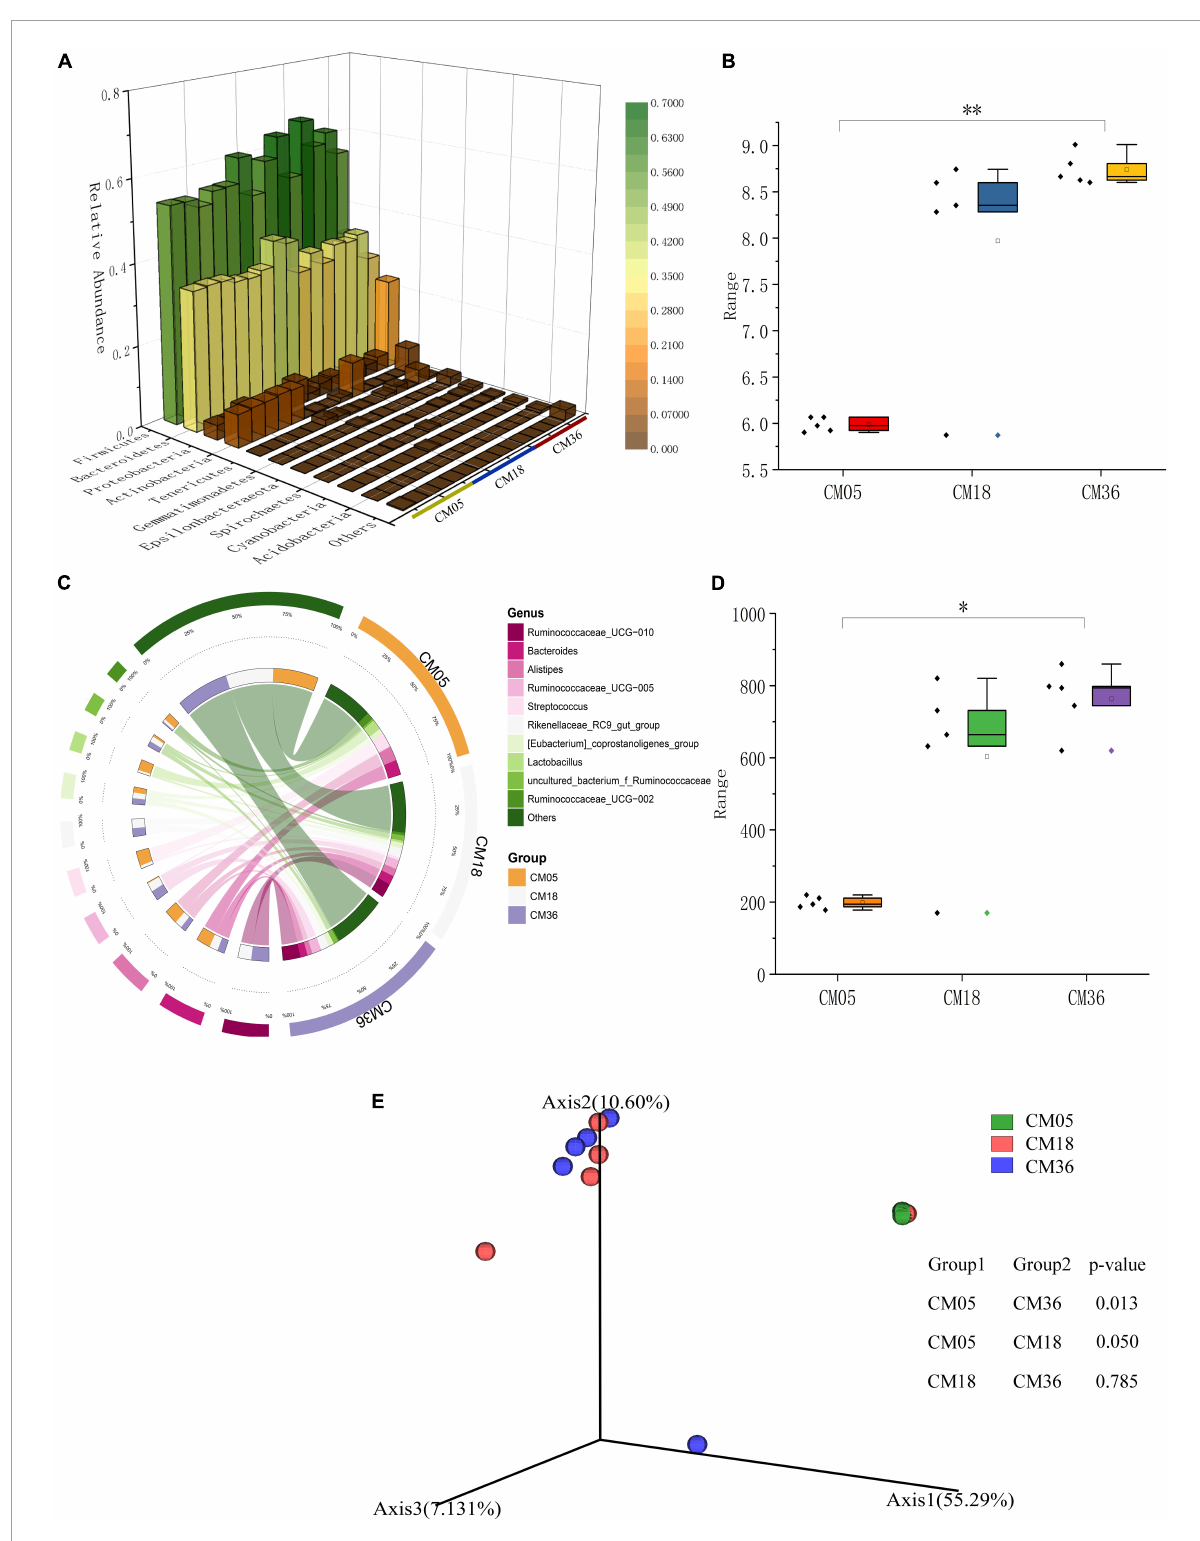
FIGURE1 Relative abundance and diversity of bacterial communities in the cecum of post-weaning Mongolian cattle. (A) Taxonomic composition of the bacterial phylum, red indicates high relative abundance and green indicates low relative abundance. (B) Shannon index of bacteria in each group (** P < 0.01). (C) Taxonomic composition of the bacterial genera. Groups are shown on the left side of the large circle, the relative abundance of bacteria is shown on the left side, and the percentage of bacteria in each group is shown on the small circle. (D) Chao1 index of bacteria in each group ( ∗ P < 0.05). (E) Principal co-ordinate analysis of cecal bacteria in post-weaning Mongolian